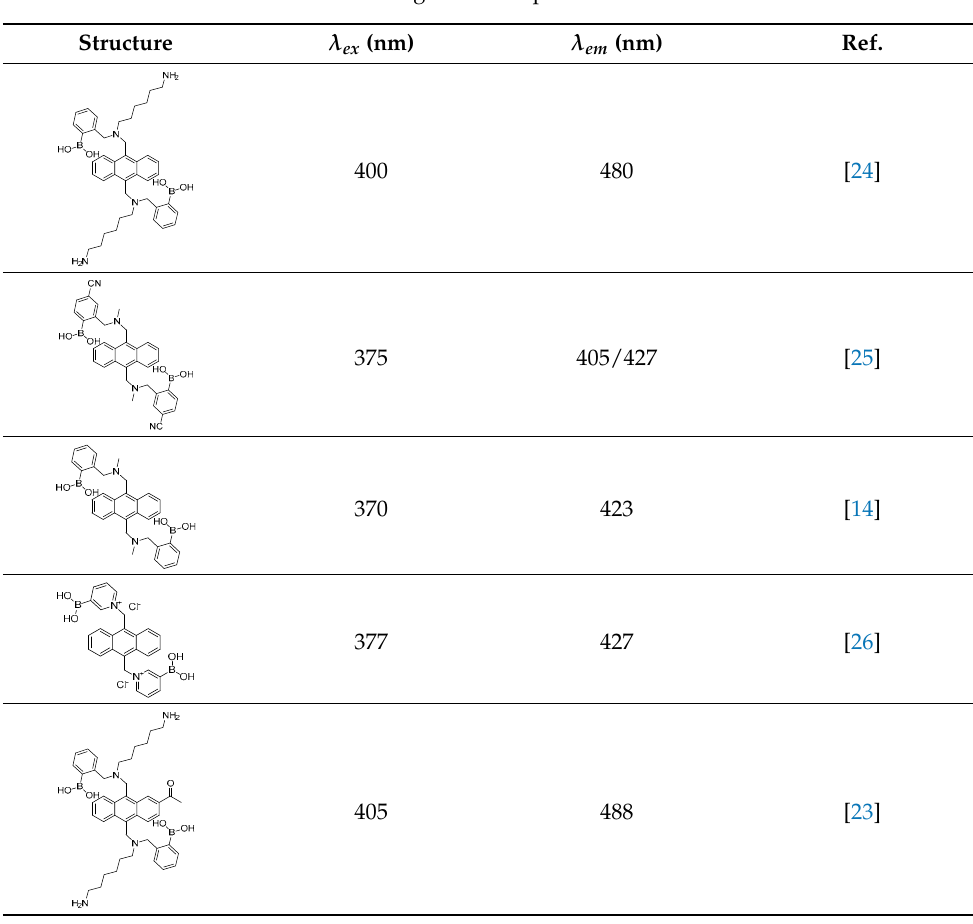
Figure 2. Comparison of oxidation resistance of AcTDA and TDA . Normalized fluorescence intensity after 4 mM H 2 O 2 was added to 20 μM of ( a ) AcTDA and ( b ) TDA with 200 mg/dL glucose in 1× PBS (pH 7.4). 3.4. Glucose-Dependent Optical Characterisitcs Next, we explored the fluorescence change of AcTDA with changes in the glucose concentration by collecting the emission spectra of the compound with various concentrations of glucose. Figure 3 shows the measured emission spectra of AcTDA mixed with glucose. In the presence of glucose, the emission spectra were blue-shifted by ~20 nm, and the intensity increased. According to the mechanism of B-N bond formation, the formation of a boronic acid complex with the diols from a saccharide, such as glucose, created intramolecular interactions between the boronic acids and amines. As shown in Figure 4, the B-N bond prevented the nitrogen lone pair from participating in photoinduced electron transfer (PET) [14,31]. As a result, the quenched anthracene fluorescence was recovered. Thus, we could observe the increased fluorescence intensity of AcTDA as the glucose level of the mixture increased. Next, we measured the association constant of AcTDA with glucose using the modified Benesi–Hildebrand plot